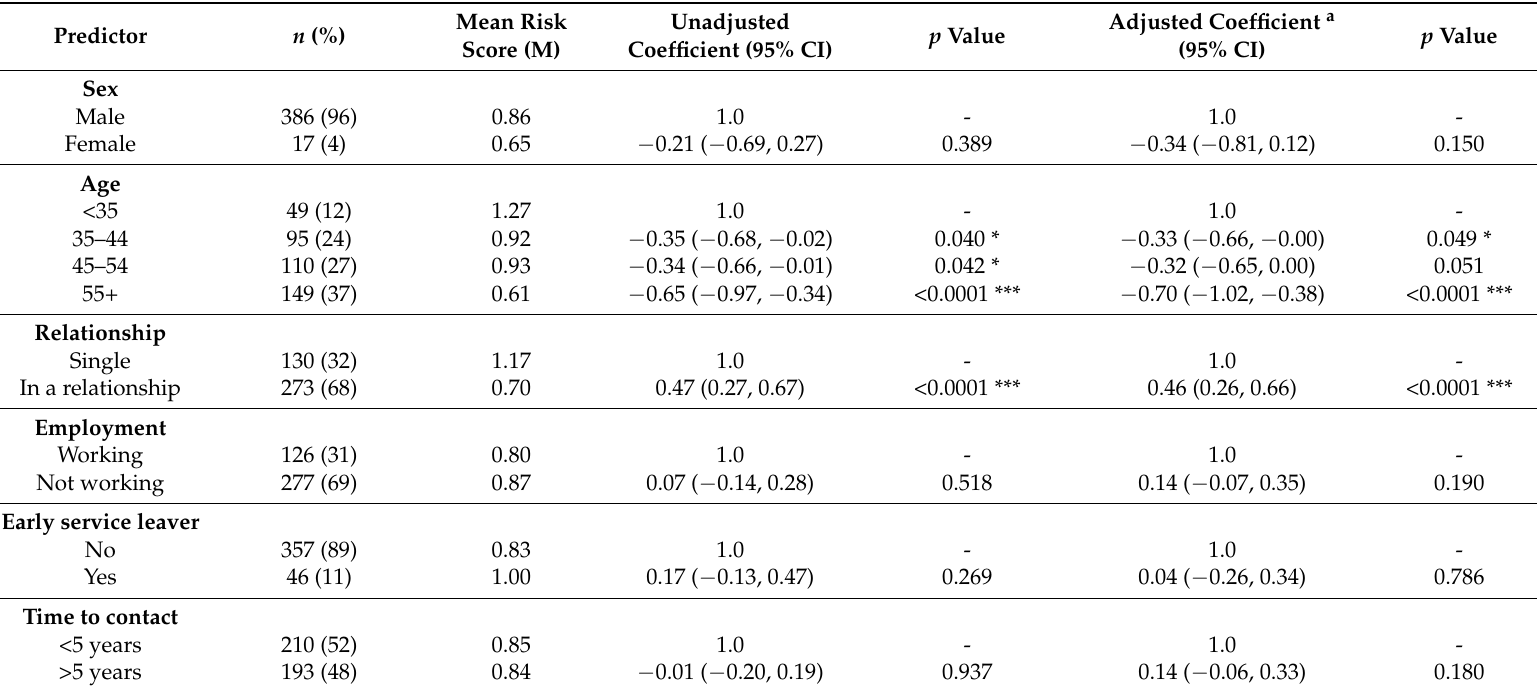
Table 2. Association between demographics and risk-taking